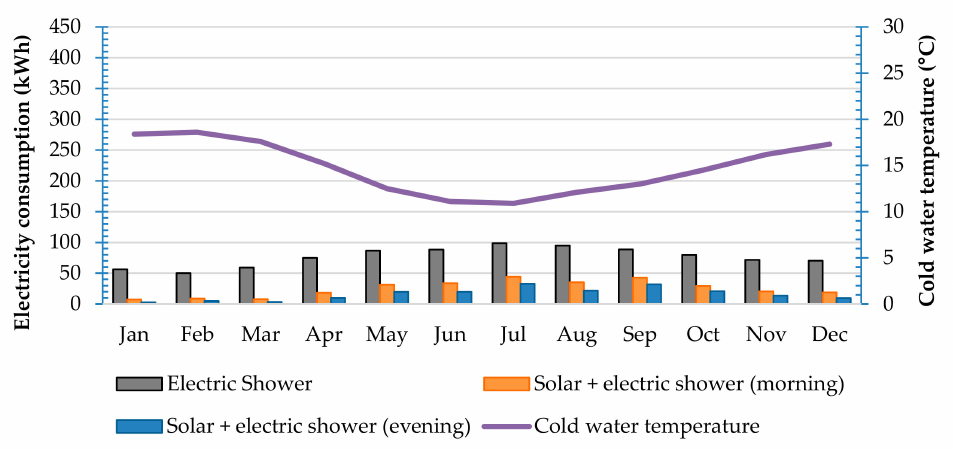
Figure 4. Electricity consumption in Curitiba.